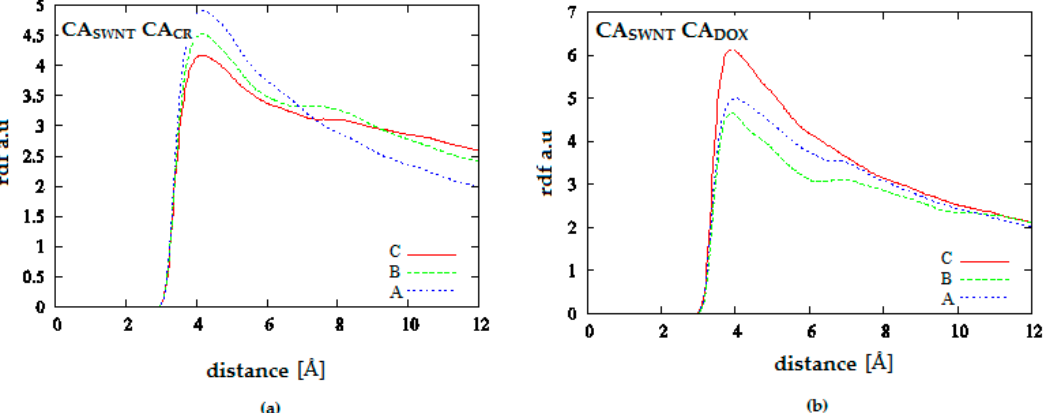
Figure 14. Radial distribution functions for the system SWNT (30.0) complexed with 20 molecules of CR and 10 molecules of DOX; ( a ) SWNT-CR interaction; ( b ) SWNT-DOX interaction; (A—neutral pH, B—medium pH, C—acidic pH).